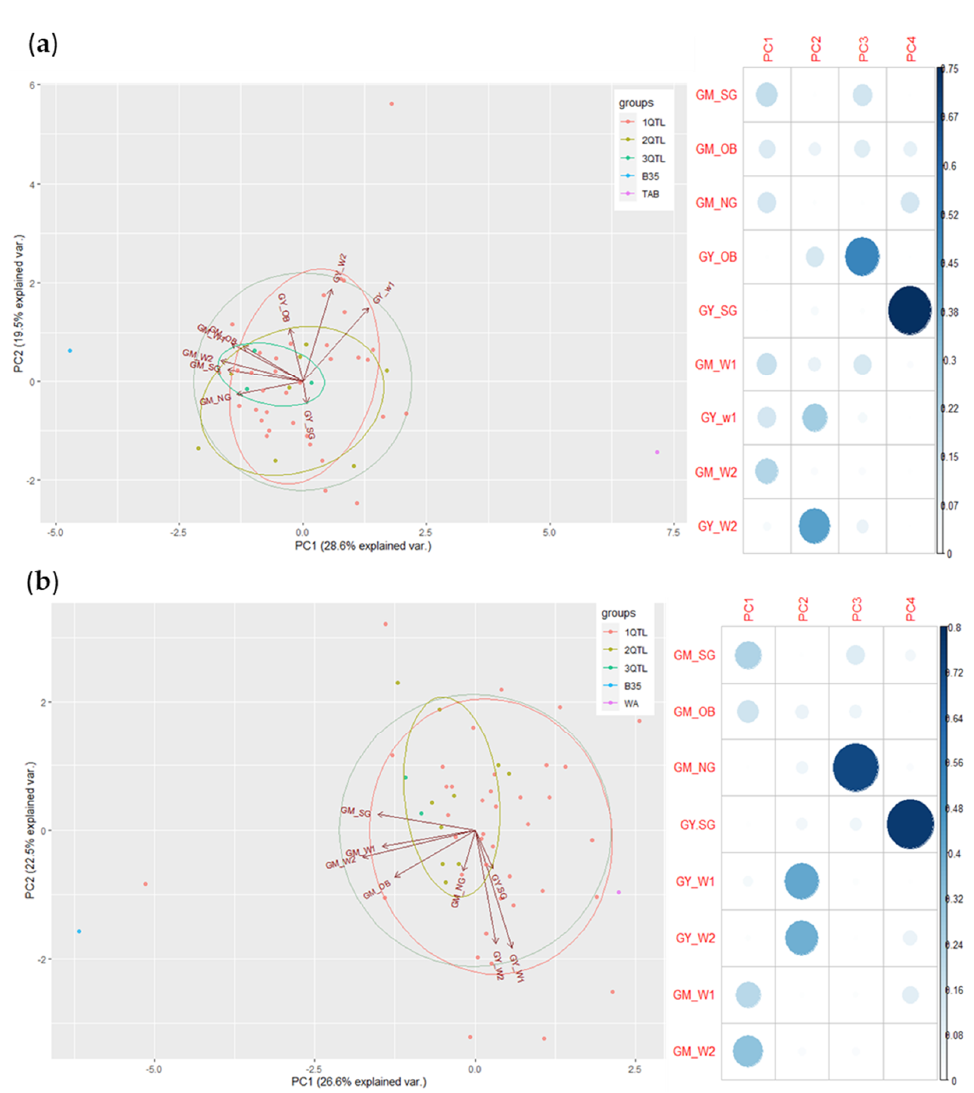
Figure 6. PCA of percentage greenness at maturity (GM) and grain yield (GY) of the ( a ) 46 and ( b ) 52 stay-green introgression lines and their parents ‘Tabat’(Tab), ‘Wad Ahmed’ (WA), and B35 tested in South Gedaref (SG), North Gedaref (NG), El Obaied (OB), and Khartoum North irrigated (W1) and drought (W2) .